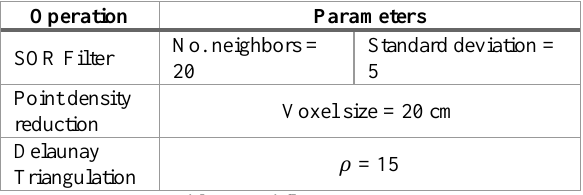
Table 1. Workflow